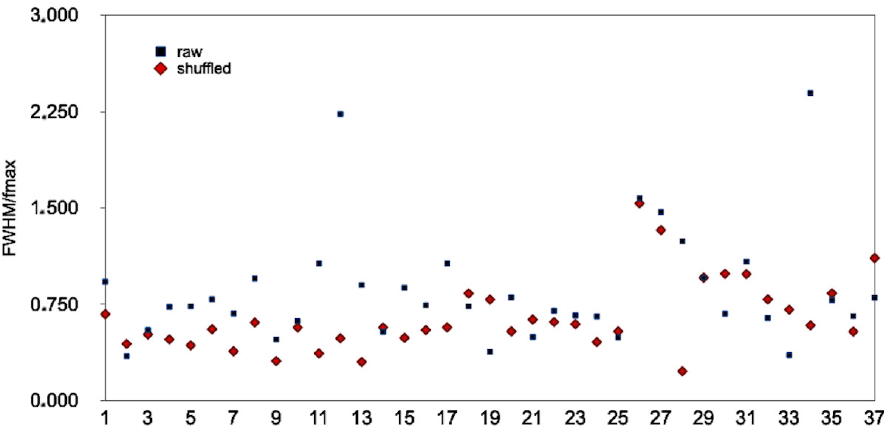
Figure 10. Scatter plot of FWHM / f max versus the i/i value of Table 2. Blue dots indicate the raw two-month series and the red dots the shuffled series.